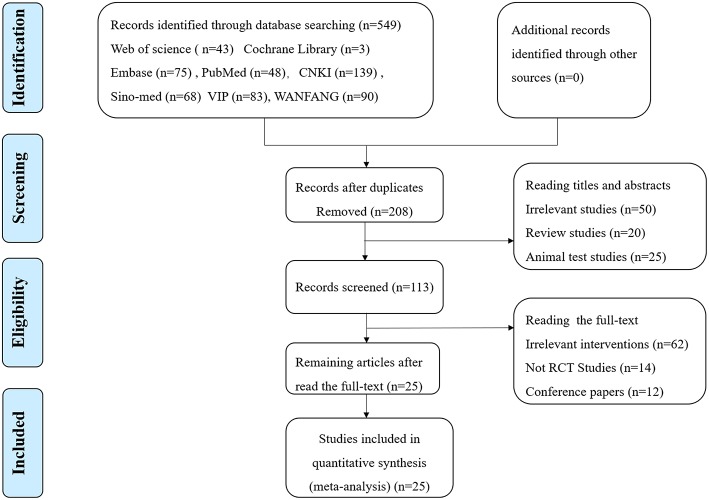
The flowchart of study selection.